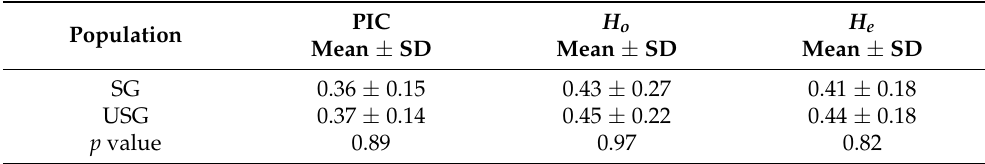
Table 1. Genetic diversity analysis of crayfish populations of SG and USG.